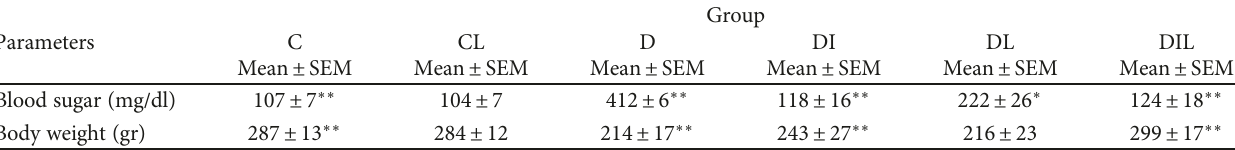
Table 2: The e ff ects of insulin or honey or both (on) blood sugar and body weight of studied rats. Parameters